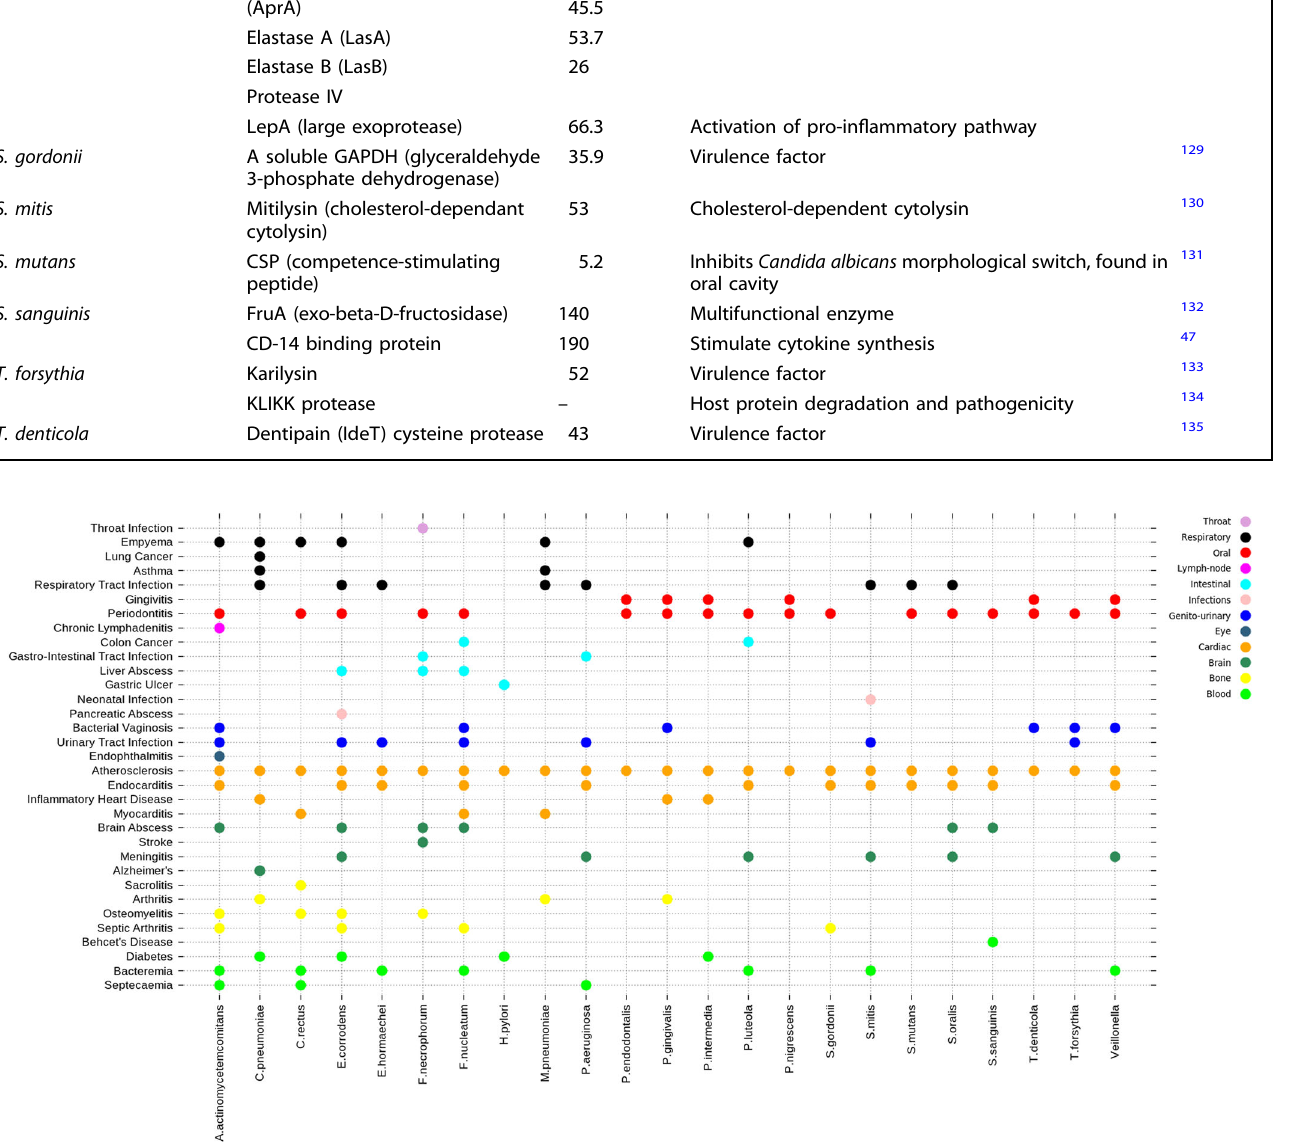
Fig. 4 Multiple diseases caused by the atherosclerotic plaque-associated bacteria. Dot plot graph for cardiac and non-cardiac diseases caused by the atherosclerotic plaque-associated oral bacteria divided into categories based on their tissue localization (prepared using GG